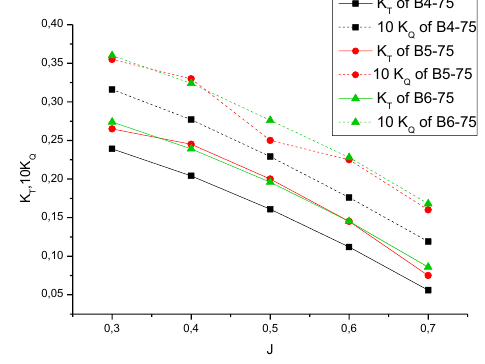
Fig. 4 . Open water characteristics.